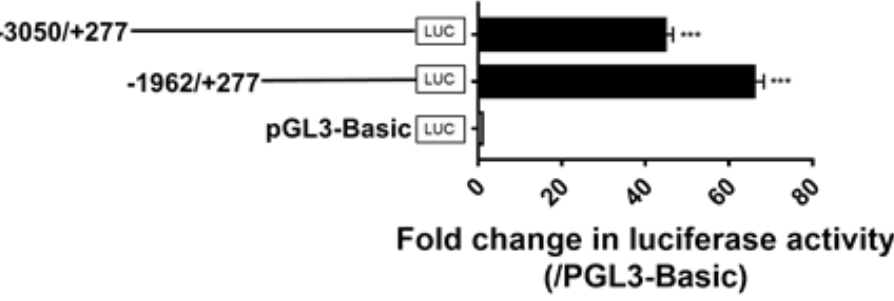
Figure 8. Detection of promoter activities of the 5 (cid:48) -flanking region of chicken GPR12 in cultured chicken fibroblast cells line (DF-1). Various lengths of the 5 (cid:48) -flanking regions of cGPR12 were cloned into pGL3-Basic vector for the generation of multiple promoter-luciferase constructs ( − 3050/+277 Luc and − 1962/+277 Luc). These promoter-luciferase constructs were then co-transfected into DF-1 cells along with pRL-TK vector, and their promoter activities were determined by dual-luciferase reporter assays. The transcriptional start site identified by 5 (cid:48) -RACE was designated as “+1” (see Figure S1). Each value represents the mean ± SEM of four replicates ( N = 4). *** p < 0.001 vs. pGL3-Basic vector.